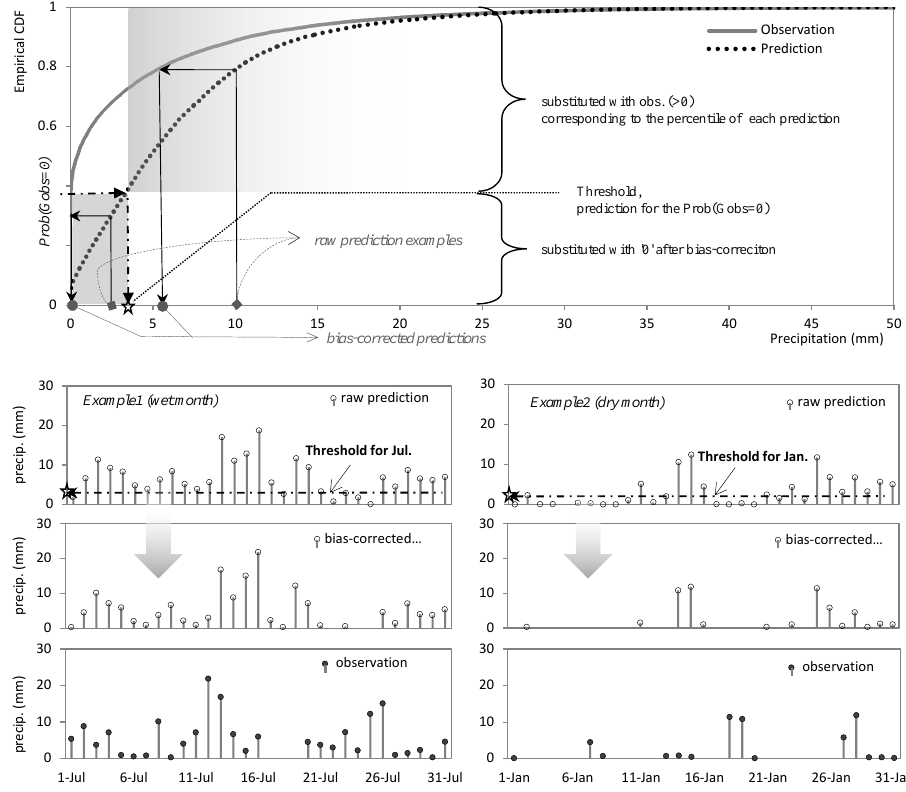
Fig. 2. Schematic representation of bias-correction procedure and examples of the raw, bias-corrected, and observed daily predictions for a wet (July, left column) and dry (January, right column) month. In the top panel of figure, Prob (G obs = 0 ) is the observed fraction of days with no precipitation. Any prediction x t,i of which CDF sim ,i (cid:0) x t,i (cid:1) is less than Prob (G obs = 0 ) will be substituted with “0” and thus frequency of al daily rainfall events is corrected in the